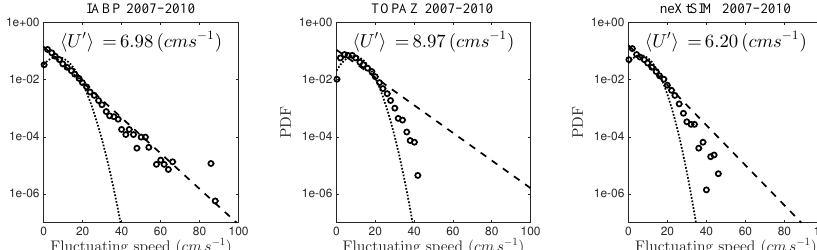
Figure 9. Probability density function of the fluctuating speed of the IABP buoys (left) and of the corresponding virtual floats in TOPAZ (middle) and neXtSIM (right) for the winter periods 2007–2010. The Gaussian (dotted lines) and exponential (dashed lines) fits of the data are also